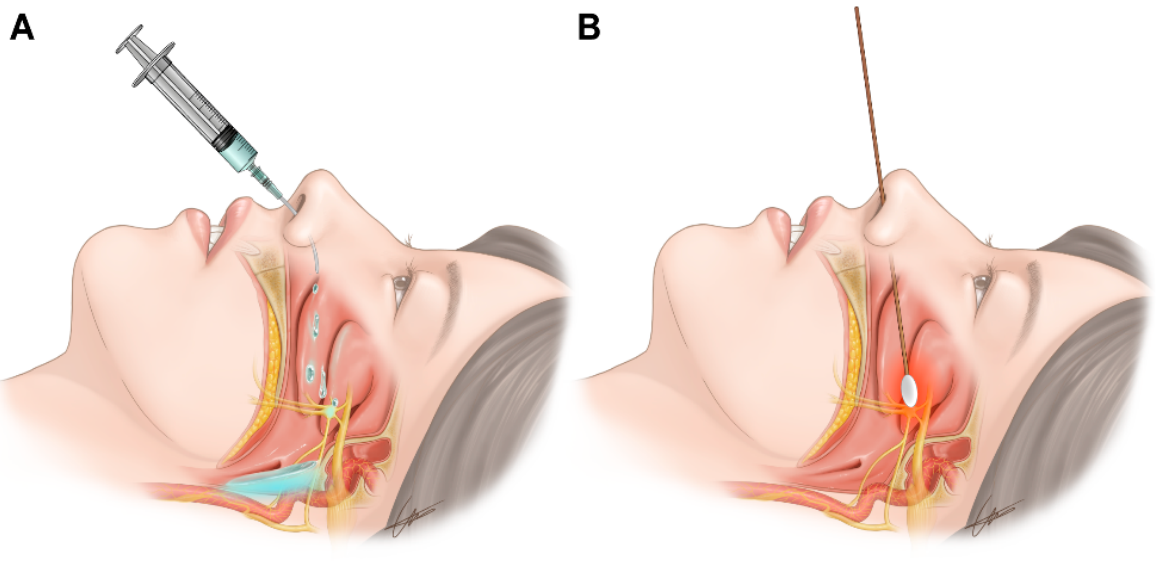
Figure 1. Transnasal sphenopalatine ganglion block by ( A ) the drip method and ( B ) topical method.